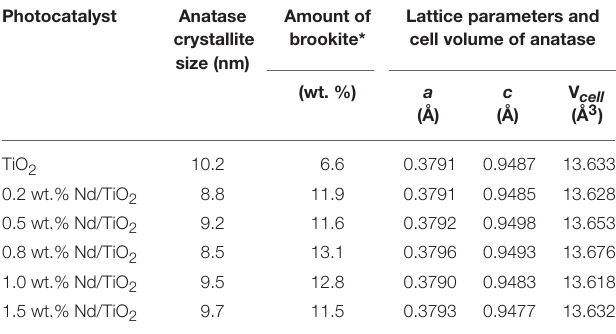
TABLE 2 | Structural and microstructural properties of investigated photocatalysts.